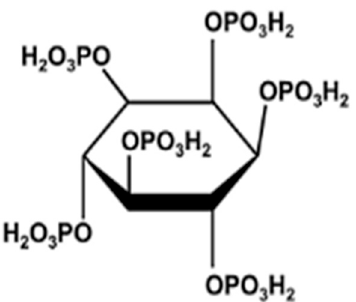
Figure 1. Molecular structure of phytic acid (Source: Higuchi et al., 2014) [20].